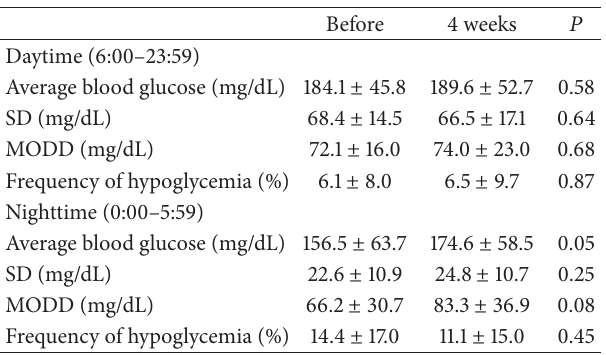
Table 3: Comparisons of glucose fluctuation and the frequency of hypoglycemic episodes over 4 days measured by iPro2 before and after switching from basal insulin to insulin degludec.